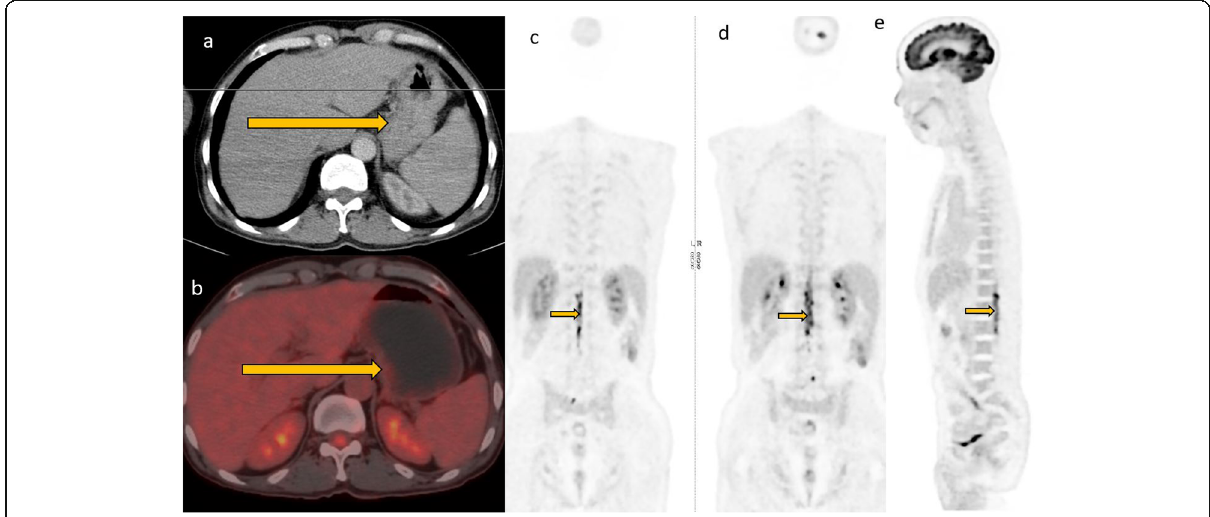
Fig. 8 Newly diagnosed HIV-positive patient who had CD4 count of 151 presented with primary gastric lymphoma. He was treated with R-CHOP regimen complicated by severe neutropenic sepsis. Intrathecal chemotherapy was deferred to cycle 3 due to poor performance. Interim PET/CT showed good treatment response of the gastric tumor but there was refractory neuraxial disease seen as FDG avid conus